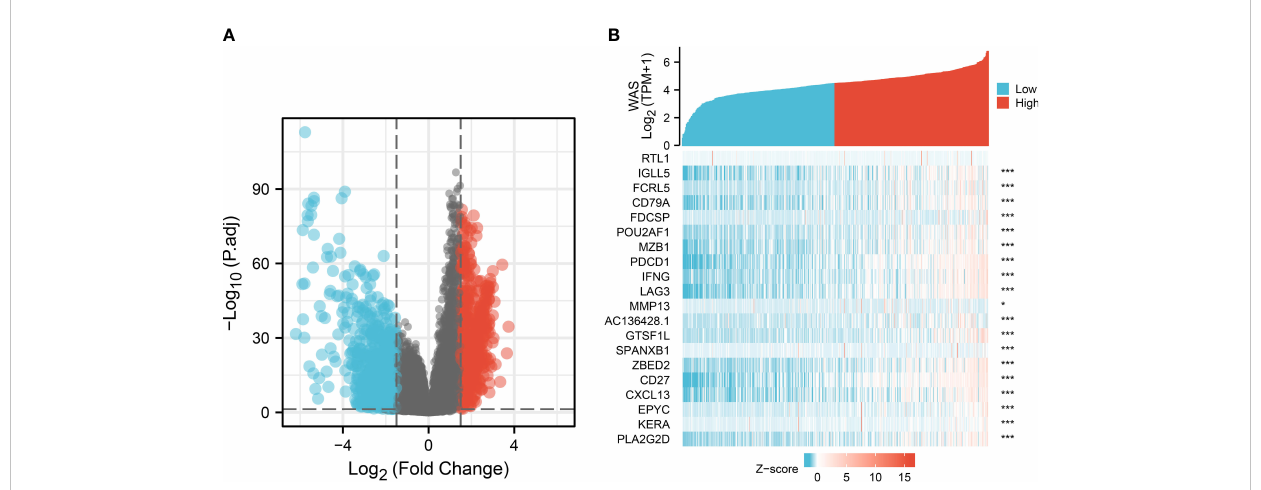
FIGURE 4 DEGs between patients with high and low WAS expression. (A) Volcano plot of differentially expressed genes between high and low WAS expression groups. (B) Heatmap of the top twenty signi fi cantly differentially expressed protein-coding genes in the two groups. Red and blue dots represent up- and down-regulated genes, respectively. DEG, differentially expressed genes.